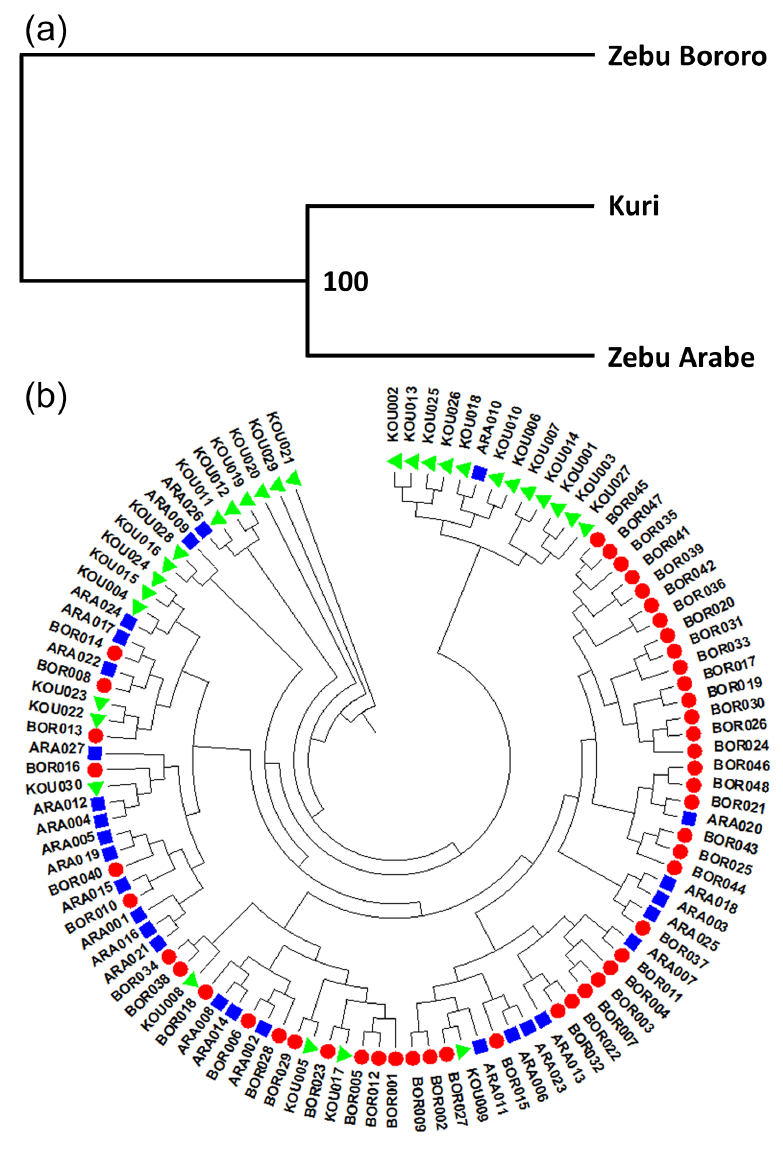
Figure 2. Neighbor-joining tree based on pairwise (a) population and (b) inter-individual allele sharing distances among Zebu Arabe (ARA), Zebu Bororo (BOR) and Kuri (KOU) breeds of Niger cattle (value at the node in a indicates percent bootstrap value out of 1000 resampled subsets of